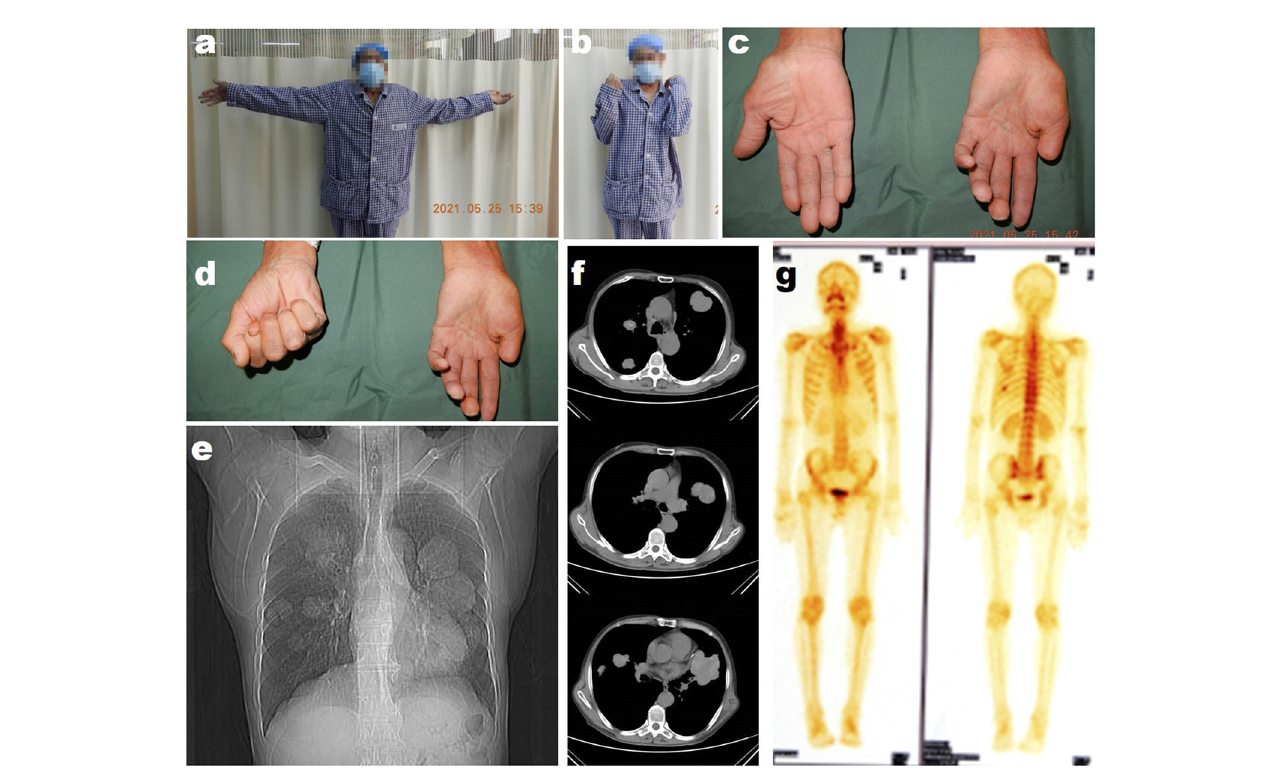
FIGURE2 The preoperative examination of the patient’s second operation in our hospital. (a) The photograph of the patient trying to abduct his bilateral shoulders. (b) The photograph of the patient trying to flex his bilateral elbows. (c) The photograph of the patient trying to extend his bilateral fingers. (d) The photograph of the patient trying to flex his bilateral fingers. (e) The radiological image of the patient’s chest. (f) The representative CT images of the patient’s chest. (g) The bone scan images of the